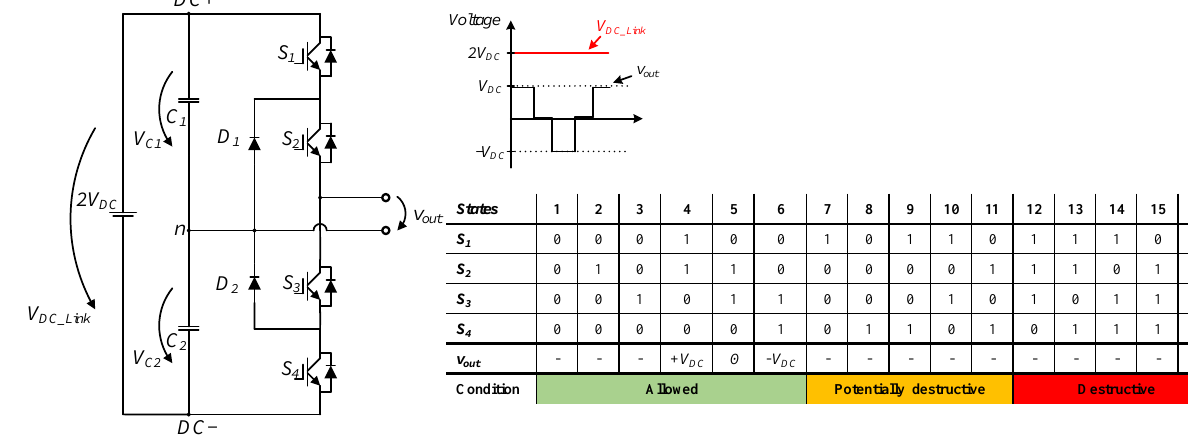
Figure 6. Conventional NPC topology and operation principle.